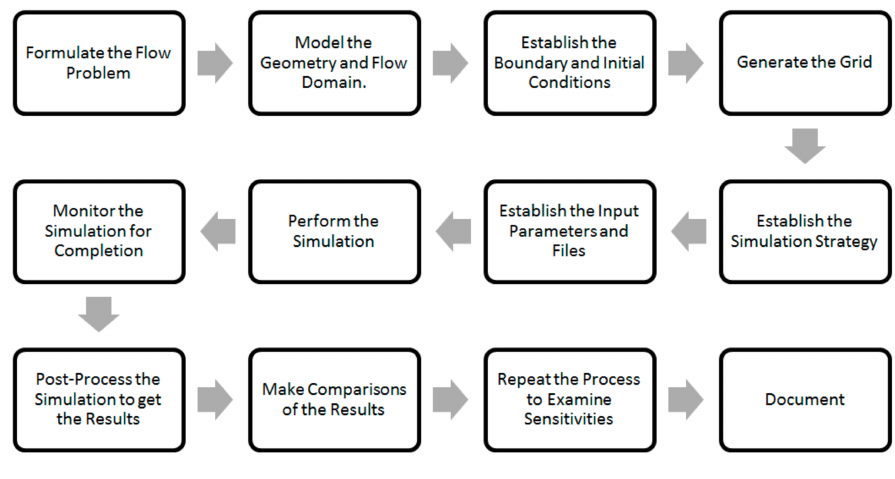
Figure 5. CFD Process.